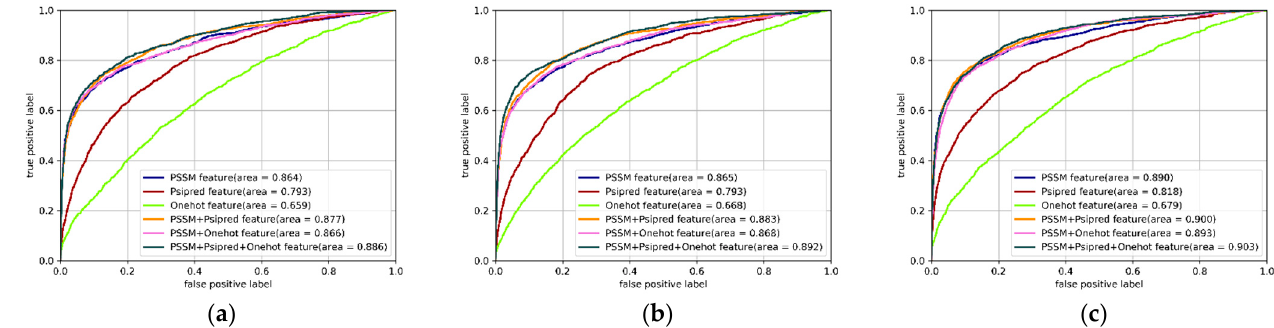
Figure 3. Receiver operating characteristic ( ROC ) curves of the multi-IncepResNet-based predictor ( a ), the multi-Xception- based predictor ( b ), and the LightGBM predictor ( c ) under different individual features and feature combinations. The corresponding area under the curve ( AUC ) values are listed in the legends.